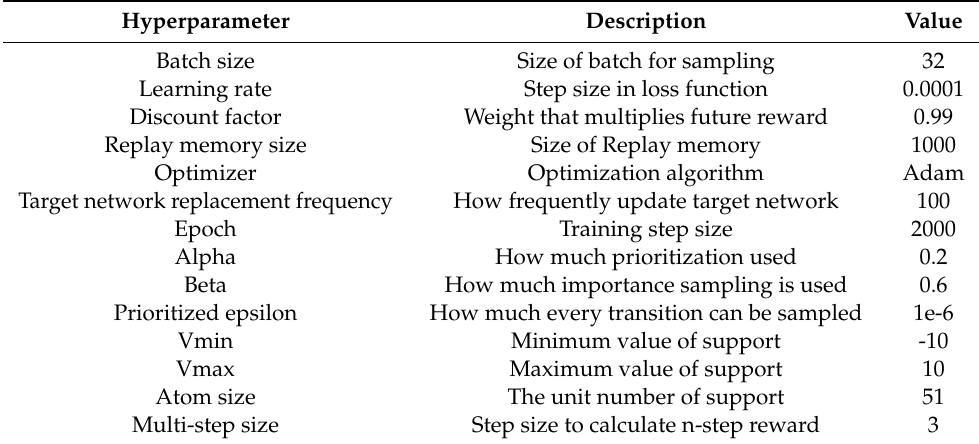
Figure 5. 4 × 4 intersection road network. Table 2. Hyperparameters for TFP-CTSC.